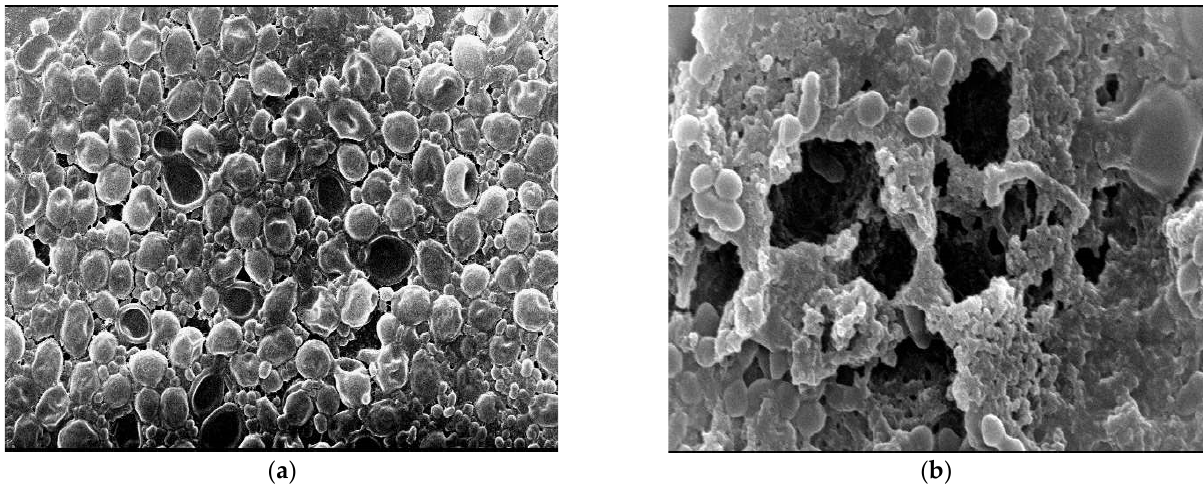
Figure 7. AgNP-treated biofilm: control (×5000) ( a ) and Mo-capped AgNP-treated biofilm (×15,000) ( b ).